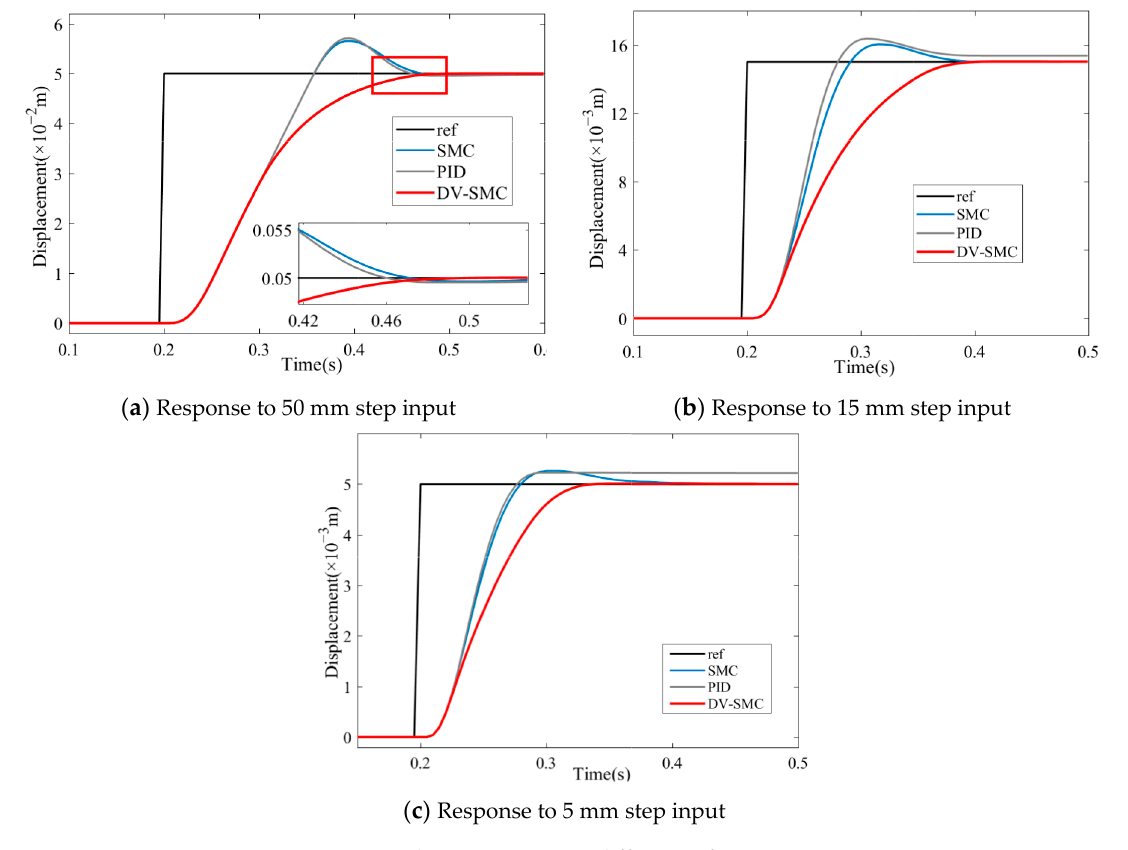
Figure 4 . Simulation response to different reference inputs. Figure 4. Simulation response to different reference